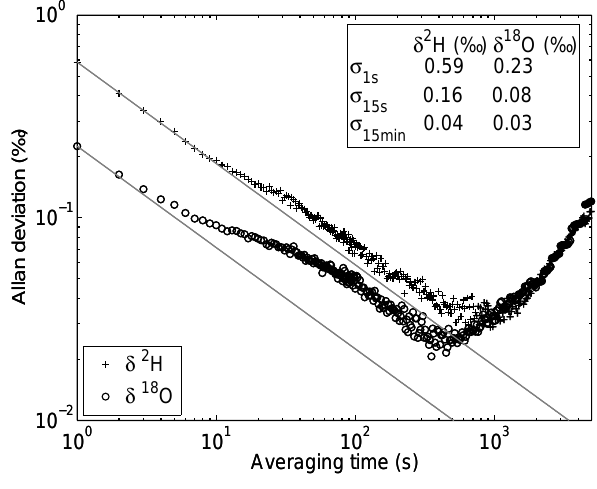
Fig. 2. Allan plots of δ 2 H (plus signs) and δ 18 O (circles) as a mea- surement of signal stability. The black lines show the theoretical slope for white noise. The upper insert shows Allan deviations (square root of the Allan variance) for different averaging